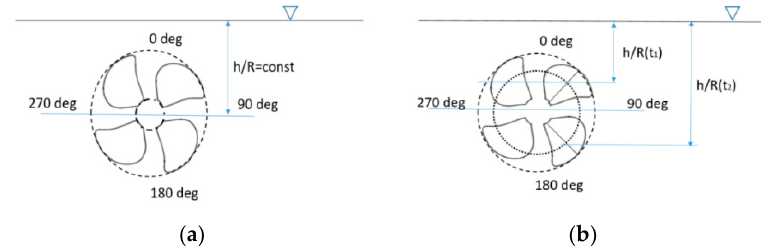
Figure 10. Modification of PropSim (2018) in order to account for the effect that the blade thrust loss due to ventilation varies during one cycle of revolution PropSim (2018_blade_dynamics). ( a ) PropSim (2018); ( b ) PropSim (2018_blade_dynamics).